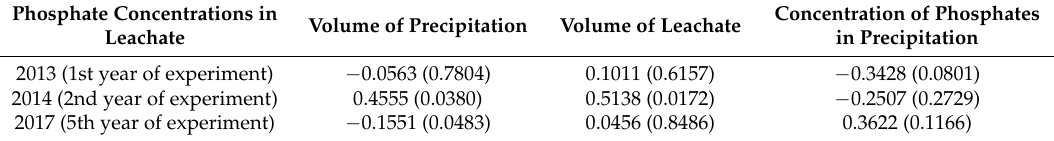
Table 5. Results of correlation analyses between phosphate concentration in leachates from the open air experiment in 2013, 2014, and 2017, and volumes of precipitation, volumes of leachate, and concentration of phosphates in precipitation, presented as Pearson correlation coefficient r and probability p (in brackets). p -values below 0.05 indicate statistically significant non-zero correlations at the 95.0% confidence